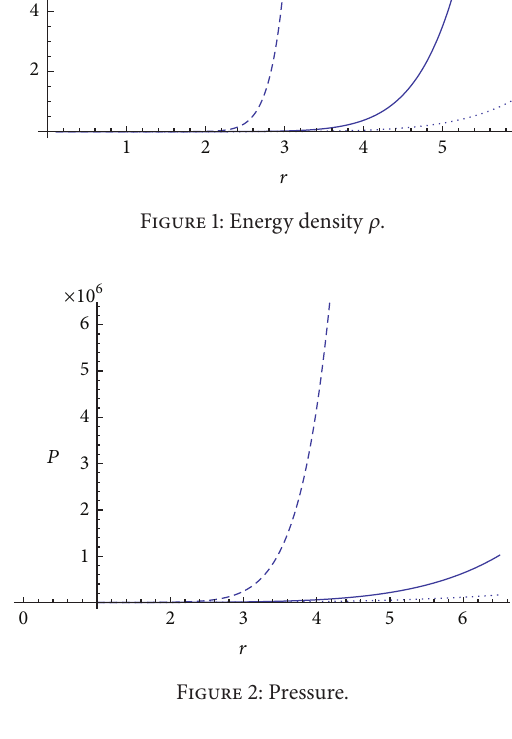
Figure 3: Heat flow.